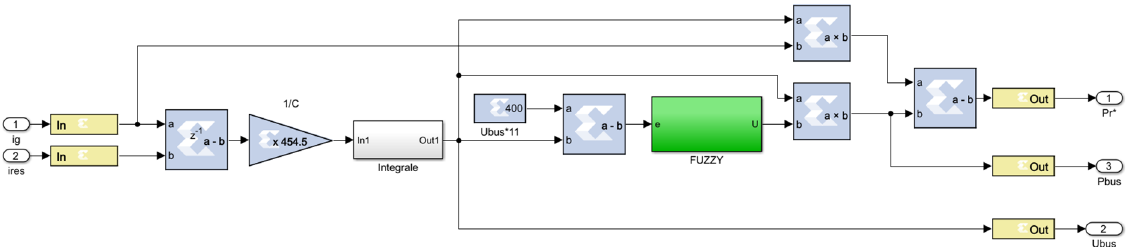
Figure (cid:561) 16. (cid:561) Hardware (cid:561) design (cid:561) of (cid:561) VCS-FGS-PID (cid:561) controllers (cid:561) for (cid:561) DC (cid:561) bus (cid:561) voltage. (cid:561) Where (cid:561) (*) (cid:561) is (cid:561) added (cid:561) to (cid:561) distinguish (cid:561) between (cid:561) the (cid:561) actual (cid:561) and (cid:561) the (cid:561) references (cid:561) variables. (cid:561) Figure 16. Hardware design of VCS-FGS-PID controllers for DC bus voltage. Where (*) is added to Figure 16. Hardware design of VCS-FGS-PID controllers for DC bus voltage. distinguish between the actual and the references